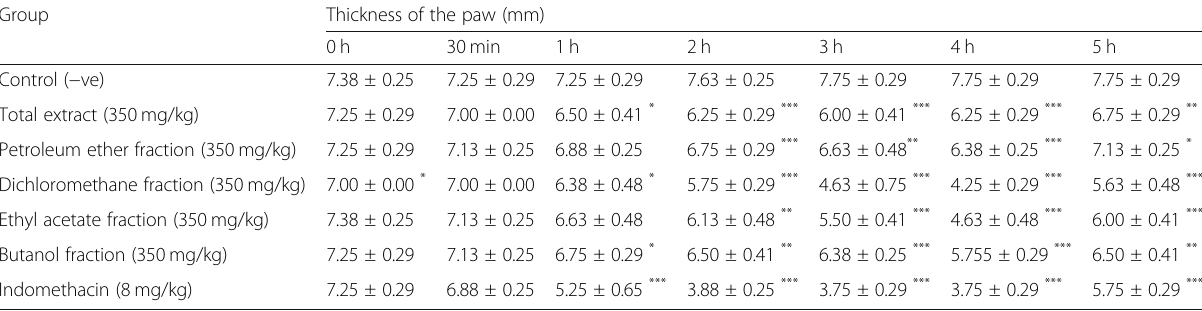
Table 5 Results of the anti-inflammatory activity of the total ethanol extract and the different fractions of C. myxa L. leaves using carrageenan-induced paw edema method Group